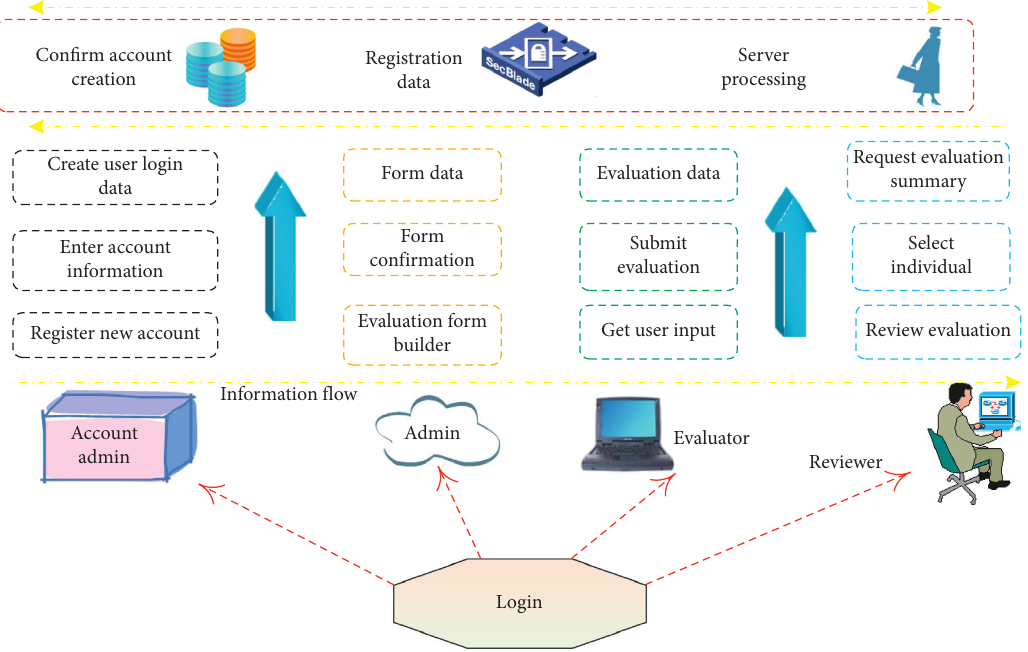
Figure 3: Evaluation model application process.